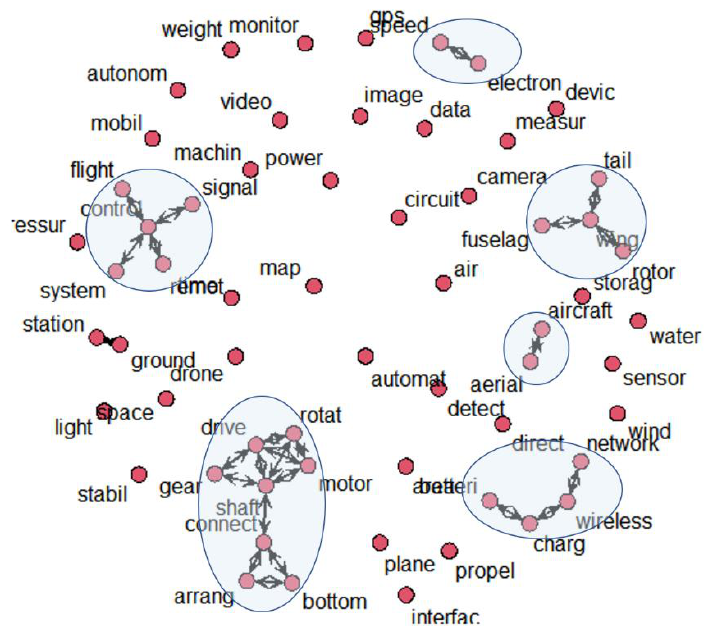
Figure 8. Keyword correlation network (correlation coefficient = 0.15).